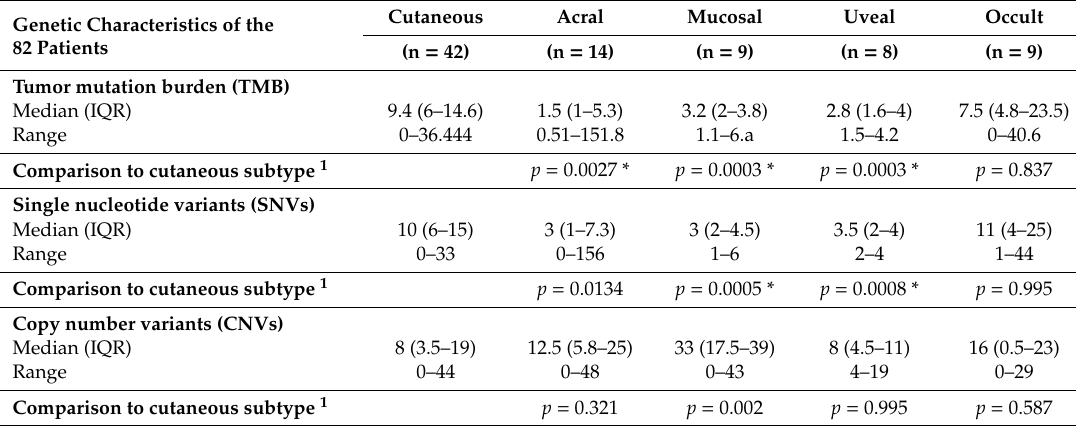
Table 2. Genetic characteristics of the 82